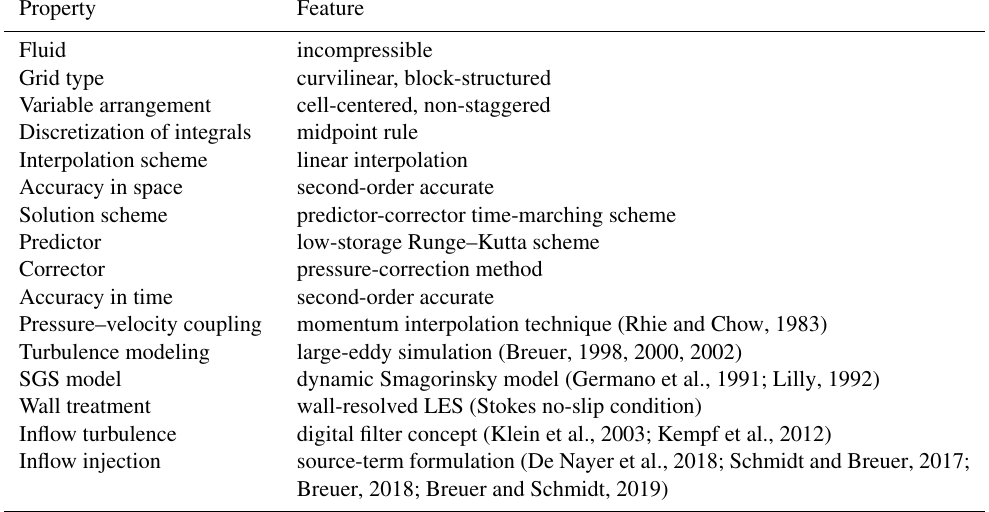
Table 1. Finite-volume method and models used for